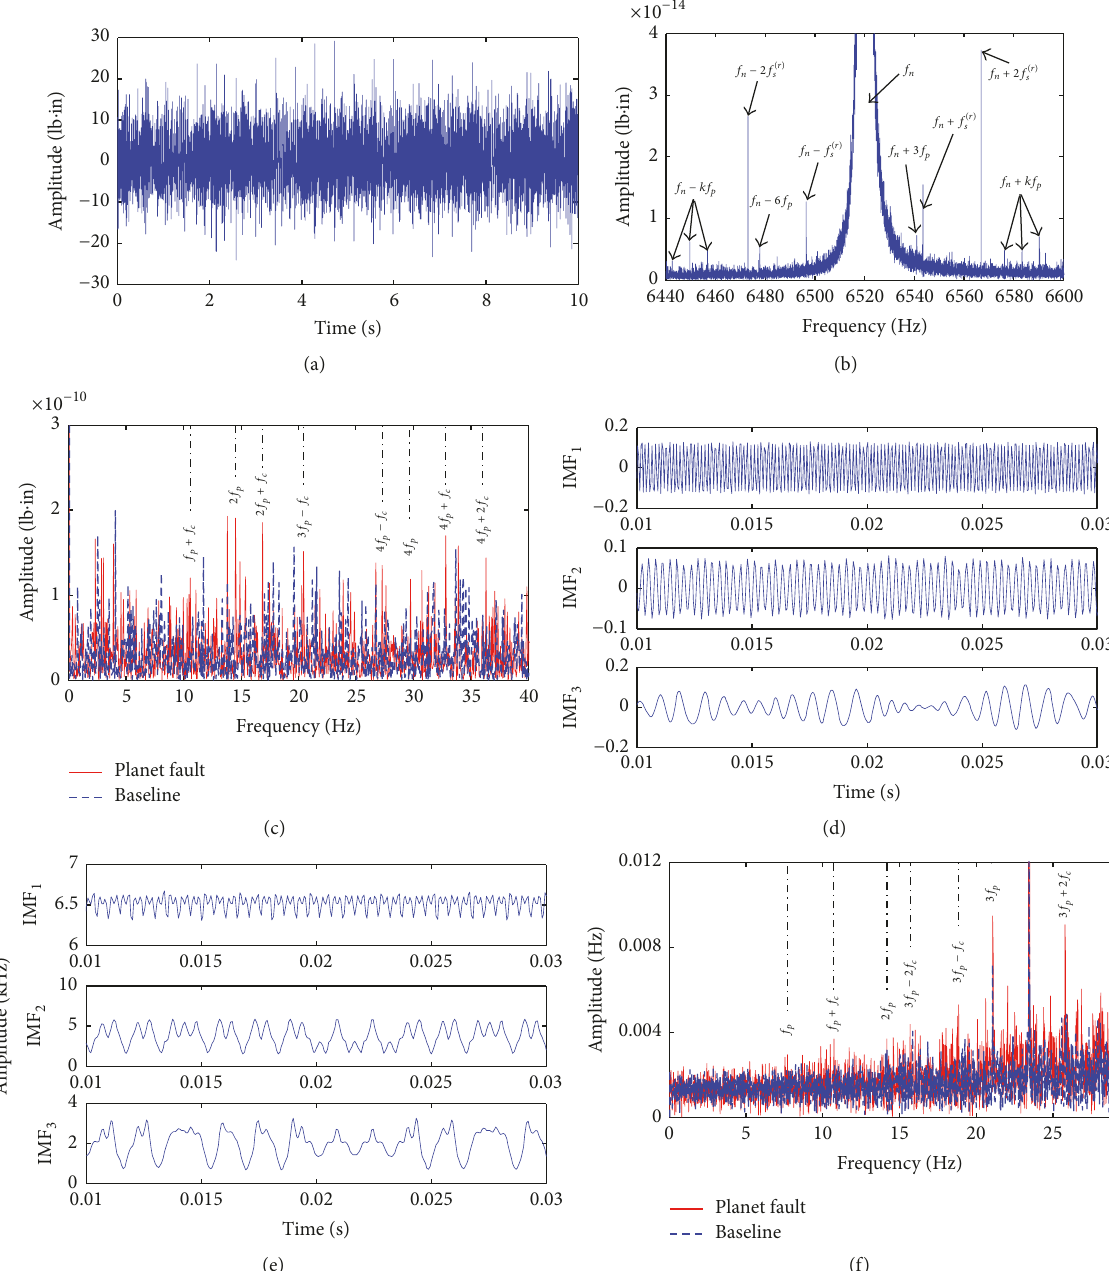
Figure 13: Planet gear fault signal analysis: (a) detrended torsional vibration signal, (b) Fourier spectrum, (c) envelop spectrum, (d) IMFs, (e) instantaneous frequencies of IMFs, and (f) Fourier spectrum of instantaneous frequency.